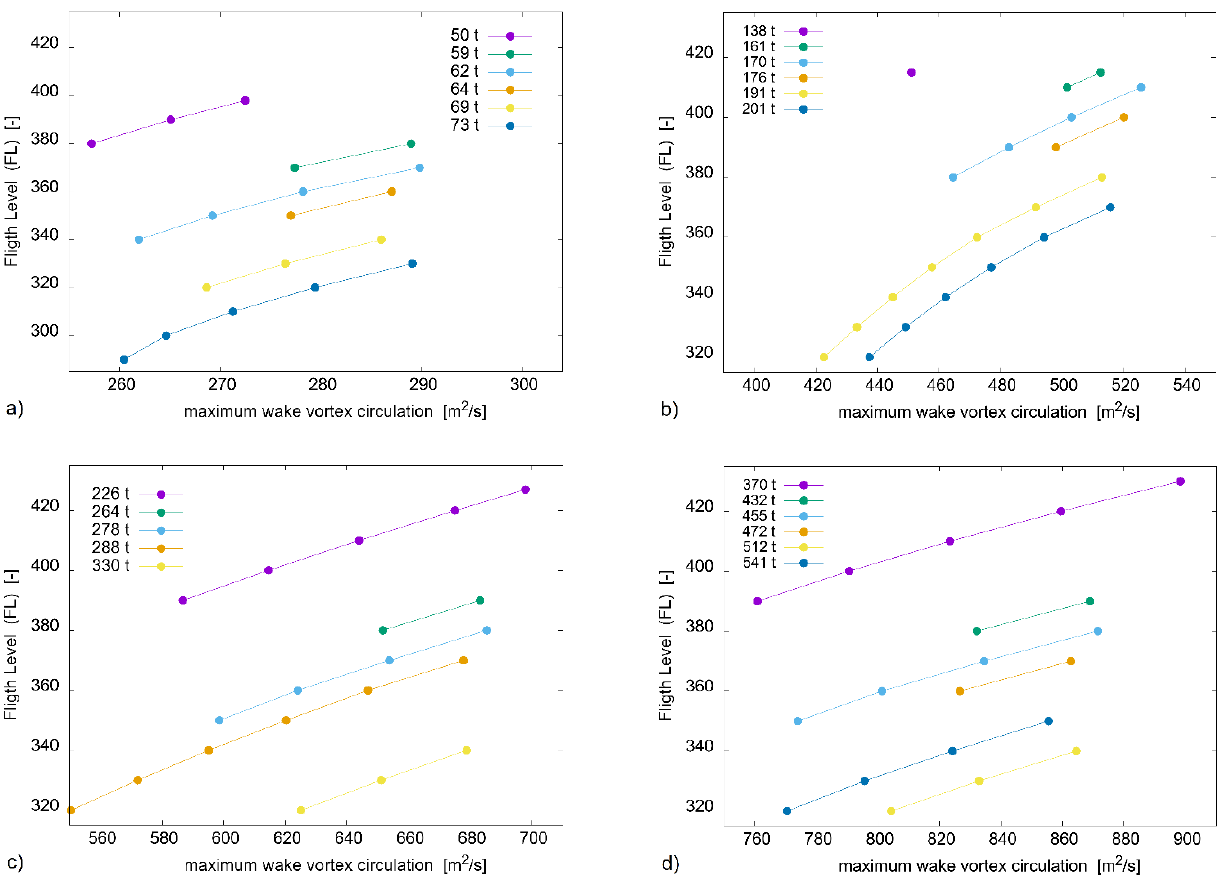
Figure 7. Maximum initial wake vortex circulation Γ 0 vs. flight level (1 FL = 100 ft) and aircraft mass (in tons), for aircraft